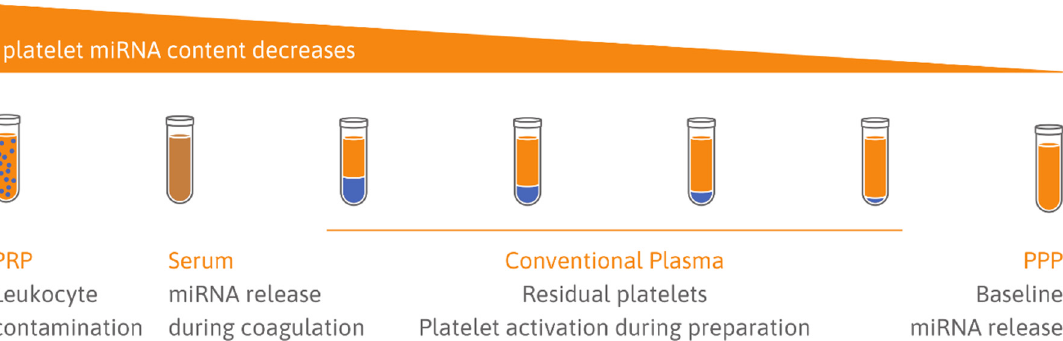
Figure 2. Platelet miRNA content in different blood samples. In platelet-rich plasma (PRP), residual leukocytes can distort miRNA measurements. Serum reflects platelet activation in conjunction with possible miRNA release as well as potentially increased degradation of miRNAs. Conventional plasma reflects the circulatory cell-free miRNA content and platelet miRNAs, depending on residual platelet count and artificial platelet activation during sample preparation. PPP is probably best suited to study the in vivo platelet secretome (adapted from [124]).